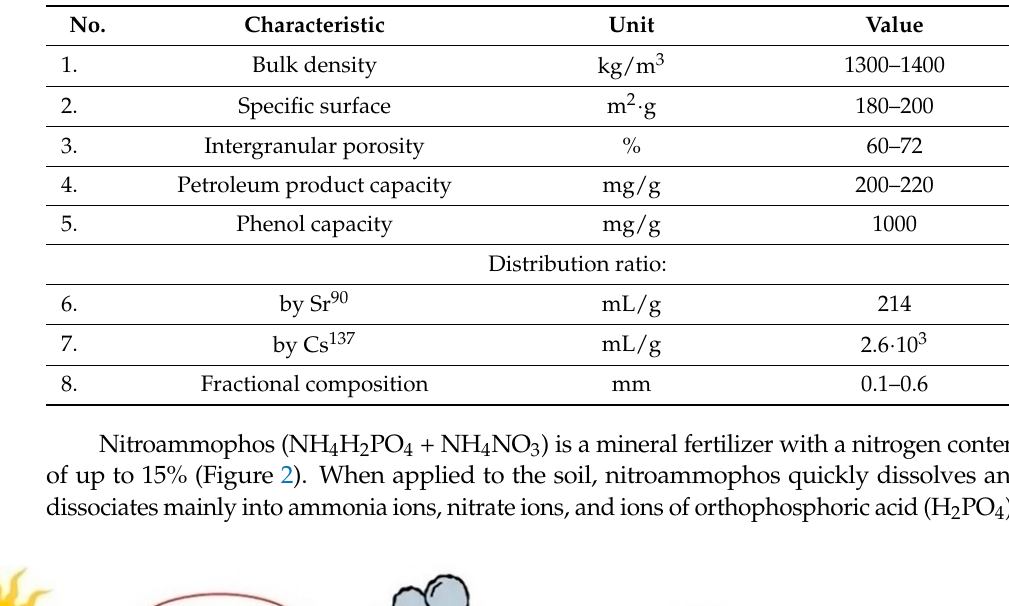
Table 1. Glauconite’s specifications [46].